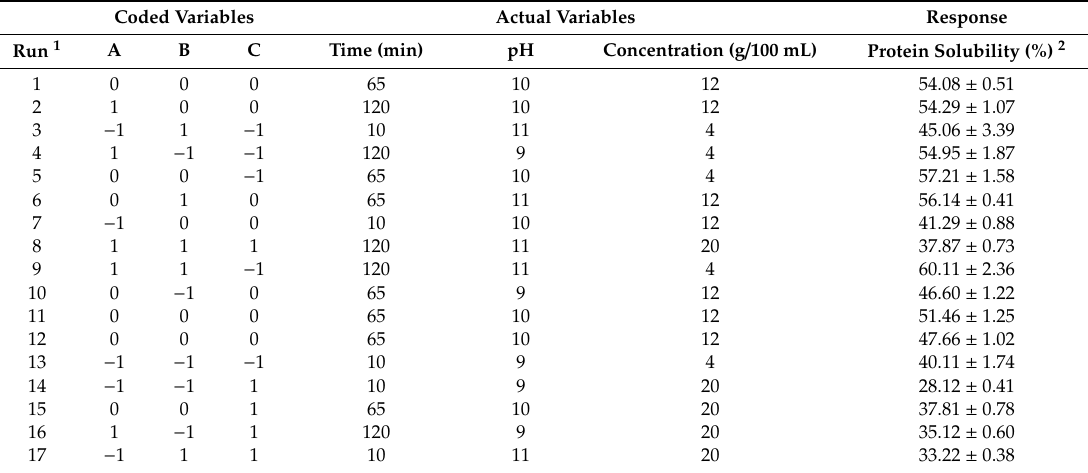
Table 1. Central composite response surface design for protein solubilisation: